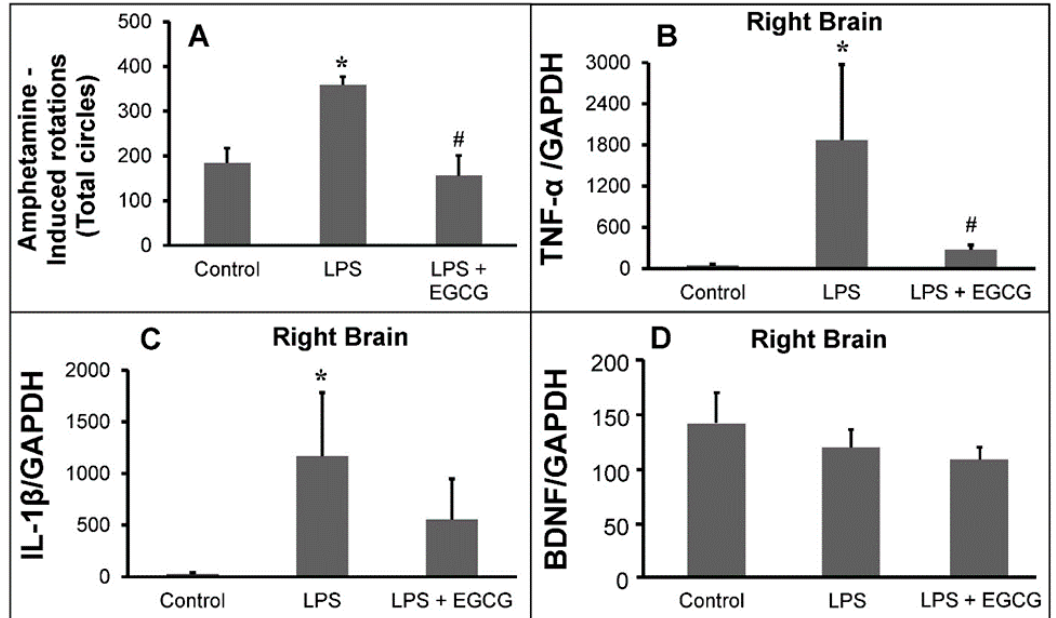
Figure 5. Animal study analysis; ( A ) effects of epigallocatechin-3-gallate (EGCG) liposomes on Parkinsonian syndrome rat rotation behavioral test ( n = 5 for the control group (injected with 5 μ L PBS); n = 4 for the LPS-induced group (with 15 μ g LPS); n = 5 for the LPS-induced and then the PC-EGCG-VE-liposome improvement group (with 15 μ g LPS and PC-EGCG-VE-liposomes with 25 μ M EGCG), for mean ± SEM, * p < 0.05 represents the comparison between the control group and LPS. No difference between the control group and the LPS+EGCG group, # p < 0.05 represents the comparison between the LPS group and the LPS+EGCG group). Expression of ( B ) TNF- α , ( C ) IL-1 β , and ( D ) brain-derived neurotrophic factor (BDNF) in substantia nigra area of rats sacrificed after rotation behavioral test, n = 3, for mean ± SEM, (* p < 0.05 represents the comparison between the control group and LPS. No difference between the control group and the LPS+EGCG group, # p < 0.05 represents the comparison between the LPS group and the LPS+EGCG group).